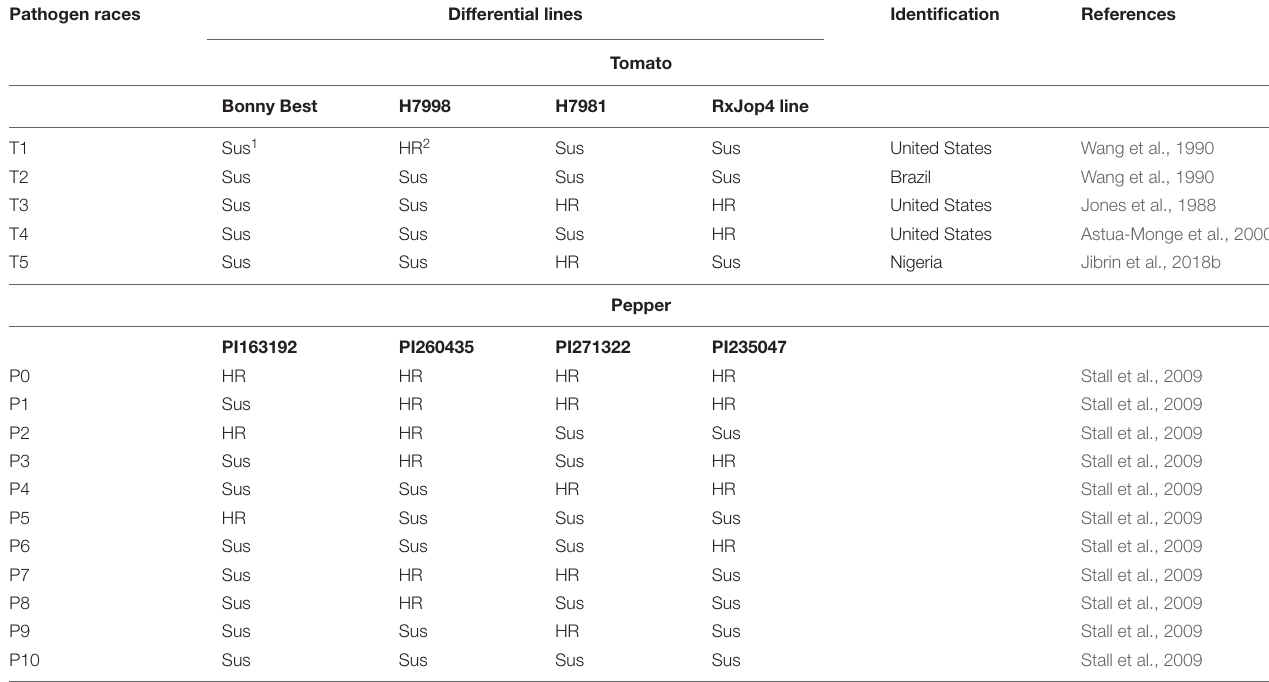
TABLE 1 | Races of bacterial spot xanthomonads following Stall et al. (2009) and emergence of race T5 in Africa. Pathogen